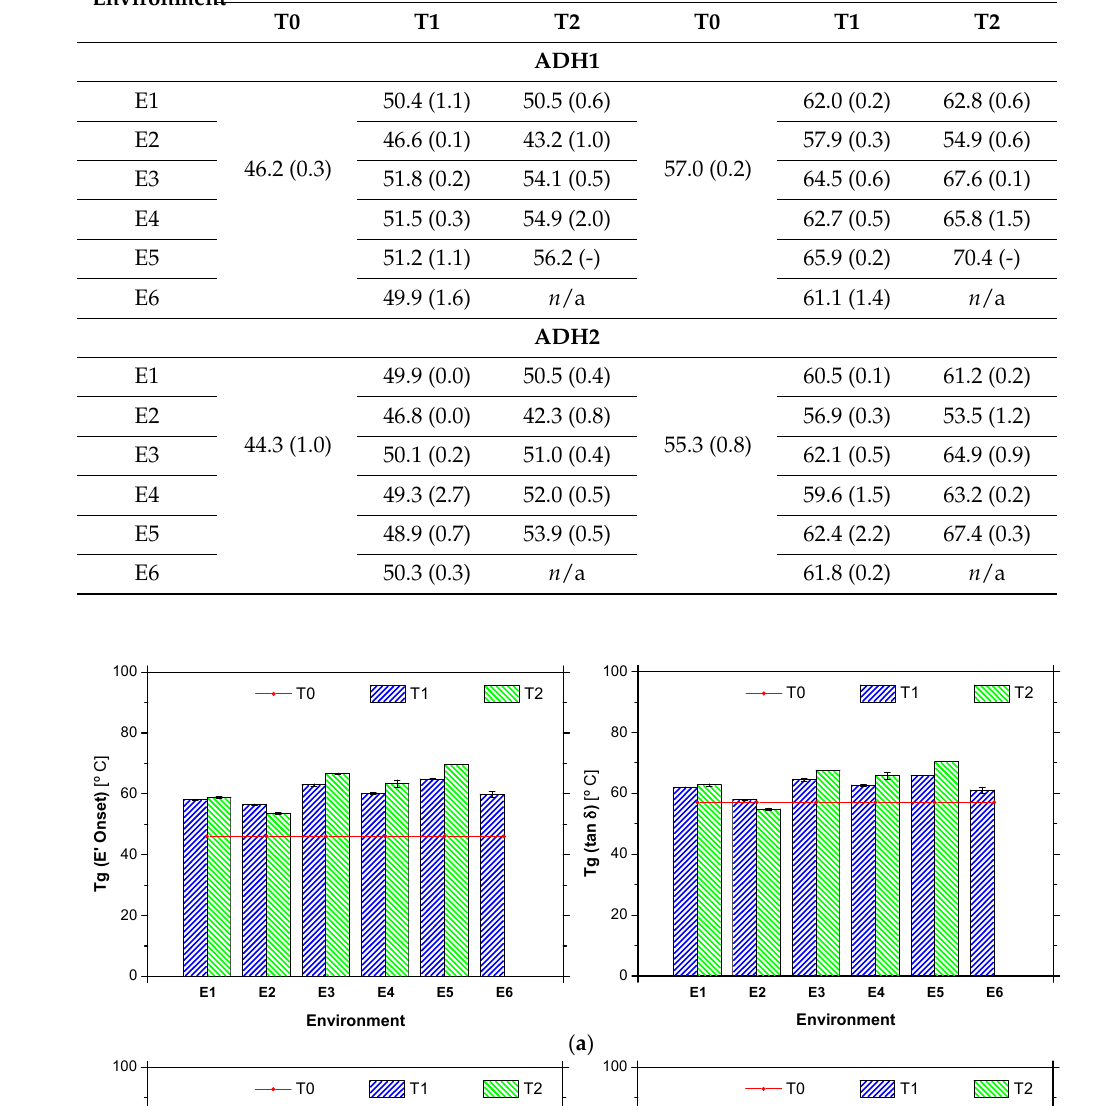
Table 4. Glass transition temperature of adhesives ADH1 and ADH2, after one year (T1) and two (T2) years of exposure to the environments studied (E1 to E6), including the reference (T0). Environment